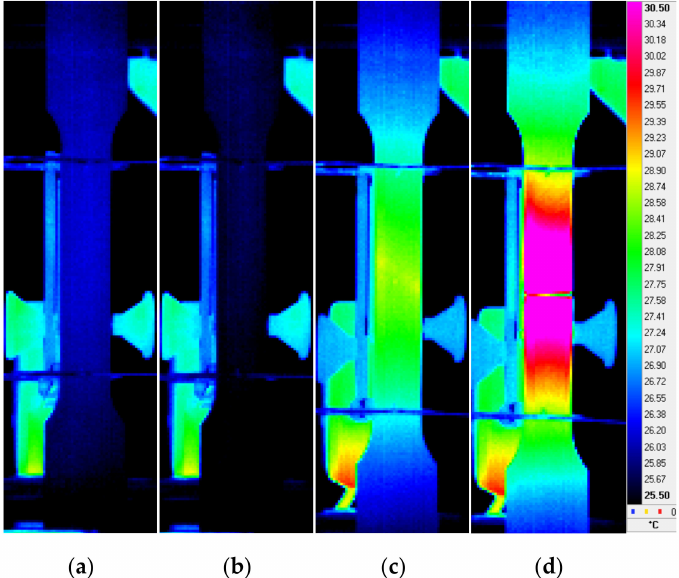
Figure 6. Selected specimen surface temperature distributions ( a – d ) obtained during the monotonic tensile test of 0.05” thick 2024-T3 aluminum alloy sheet